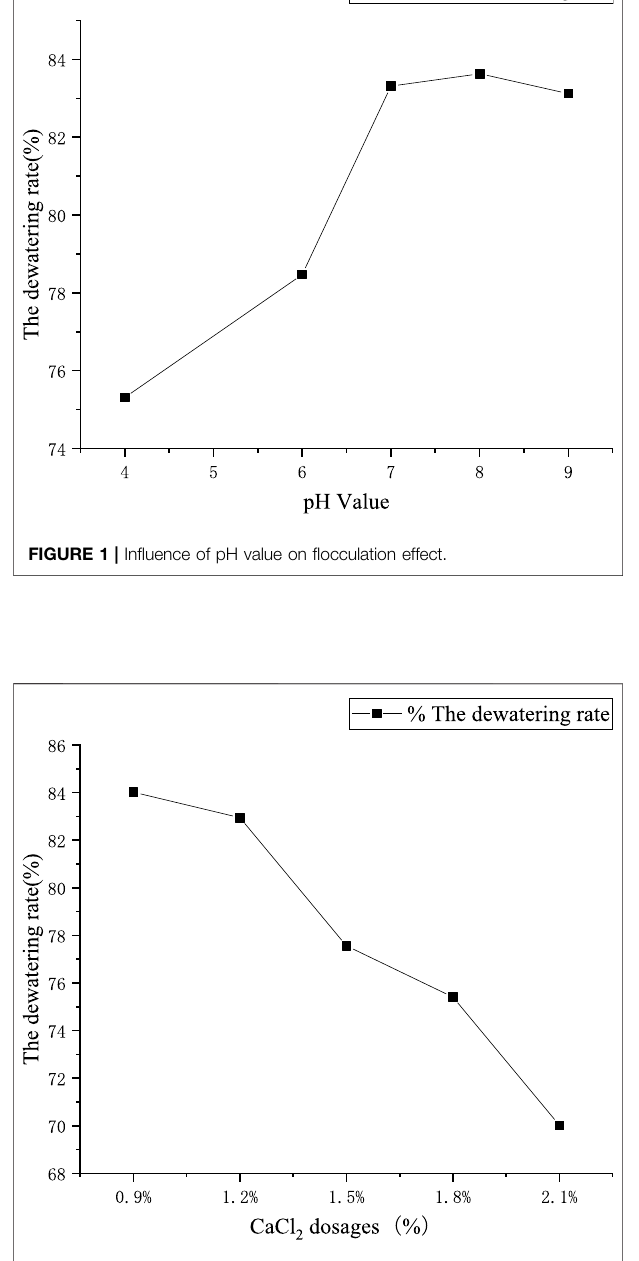
FIGURE 2 | In fl uence of CaCl 2 addition on fl occulation effect.